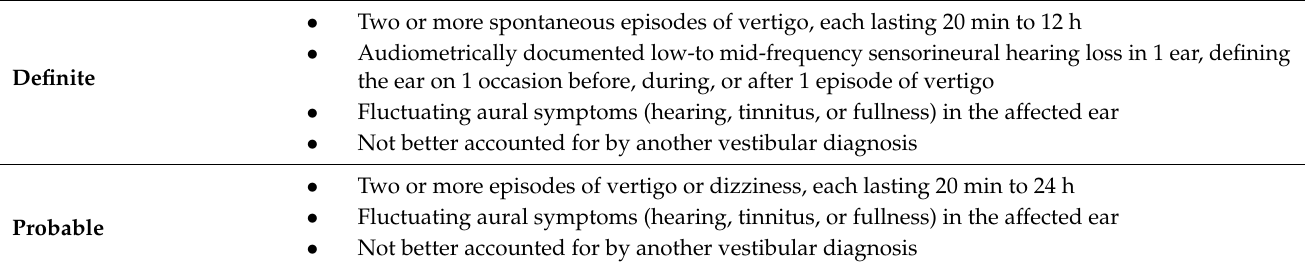
Table 2. Amended 2015 Criteria for Diagnosis of MD